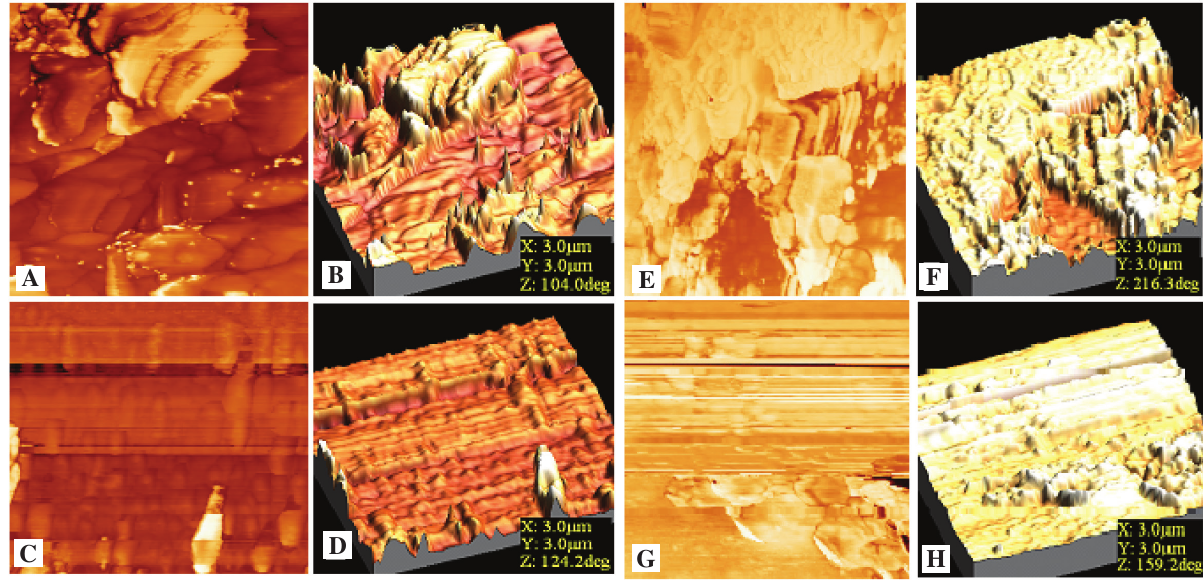
Figure 7: Tapping mode AFM images of (A, B) BPA-SPAES, (C, D) cr-BPA-SPAES-11 and (E, F) 6F-SPAES (G, H) cr-6F-SPAES-11 membranes, respectively.